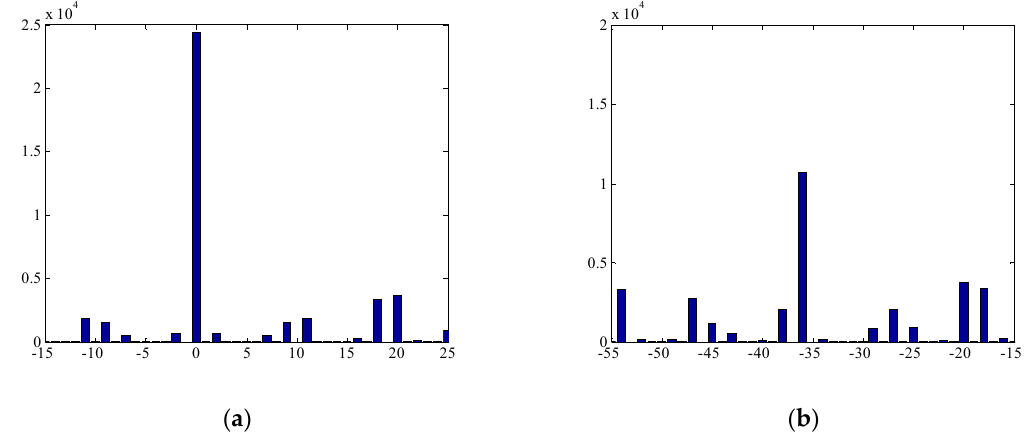
Figure 5. Magnified versions of some parts of Figure 4. ( a ) Bins around b 0 . ( b ) Bins around b -36.